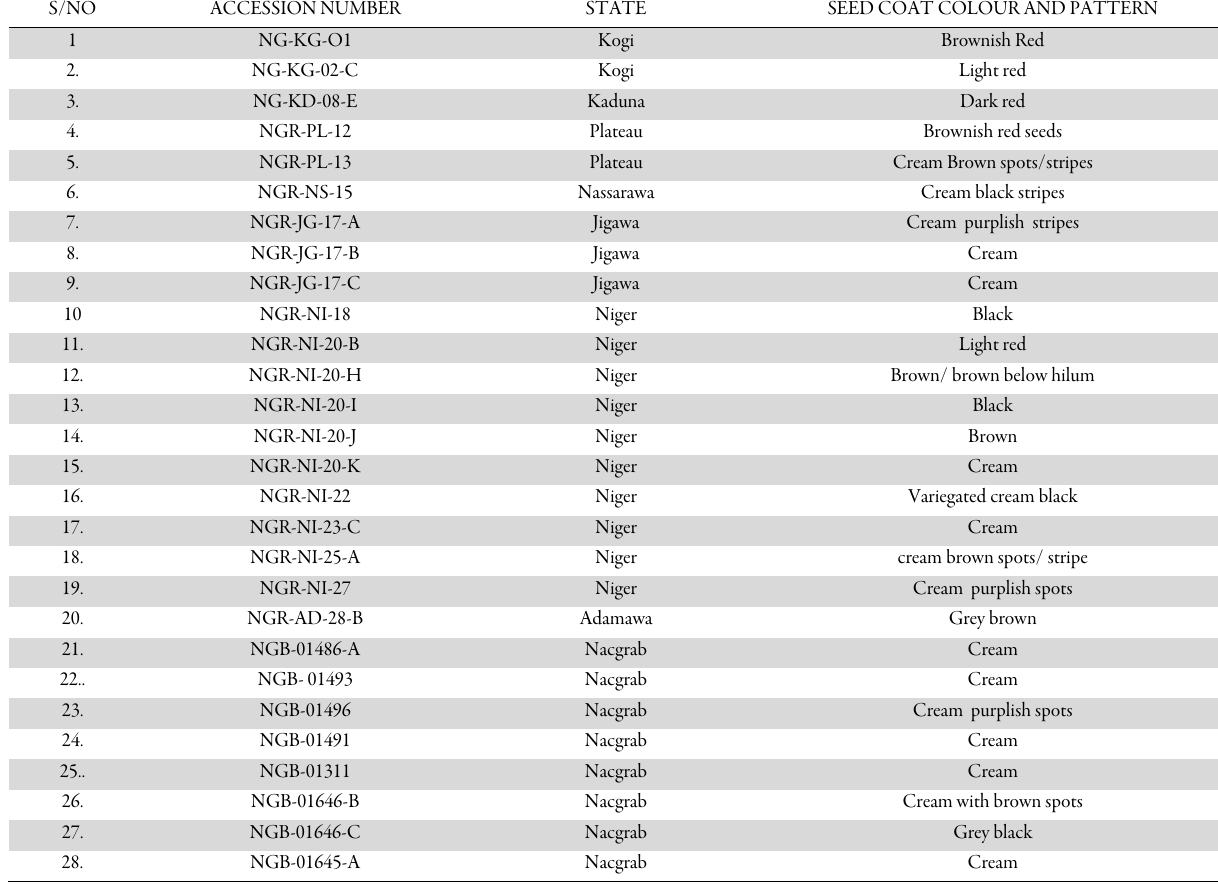
Table 1. Sources of Bambara groundnut accessions used in the study